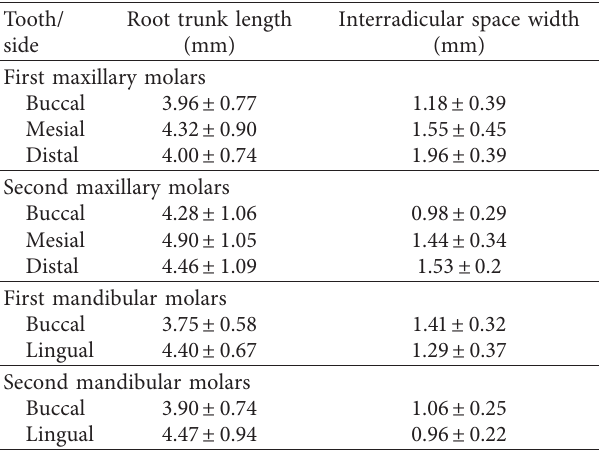
Table 2: Means ± SD (standard deviation) of root trunk length and interradicular space width of investigated teeth.